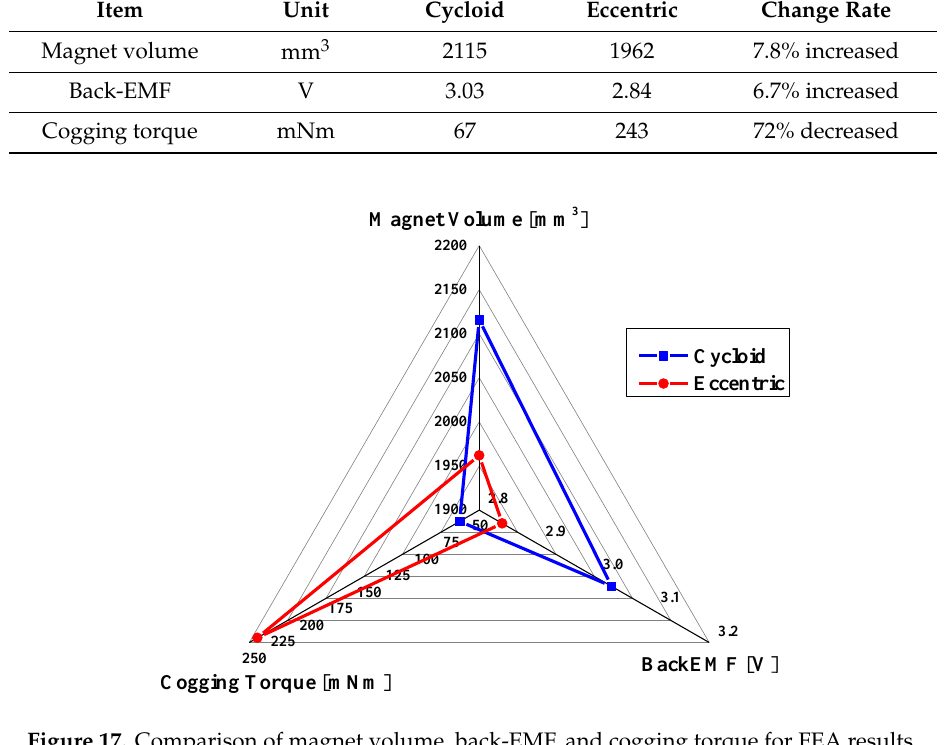
Figure 17. Comparison of magnet volume, back-EMF, and cogging torque for FEA results.